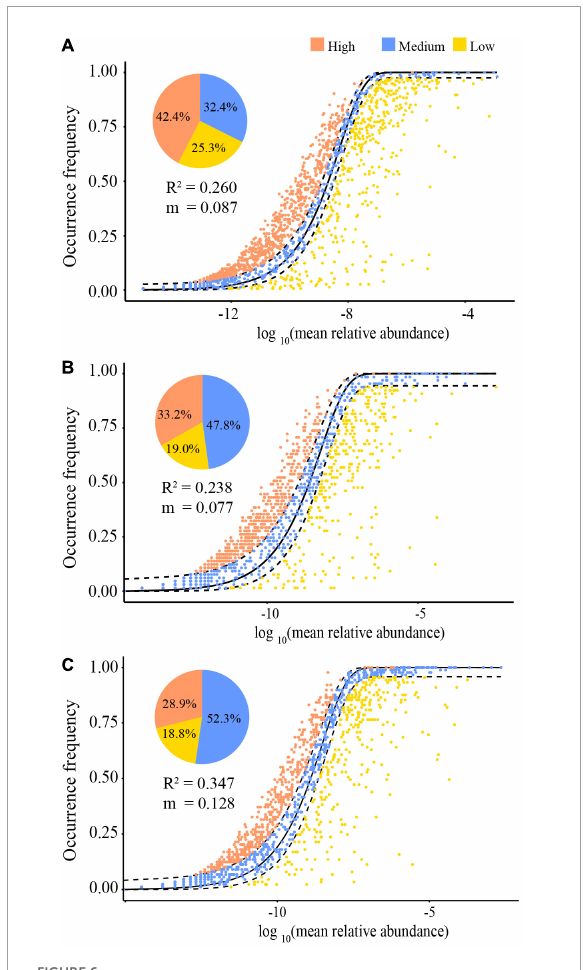
FIGURE6 The quantitative results of stochastic processes in the community assembly of the gut microbiome in all samples (A) , dry season (B) , and the rainy season (C) , based on the NCM (the solid black lines represent the best fit to the NCM, and the dashed black lines represent 95% confidence intervals around the model prediction. OTUs that occur more or less frequently than predicted by the NCM are shown in different colors. “m” represents the migration rate, and “R 2 ” represents the fitting to the